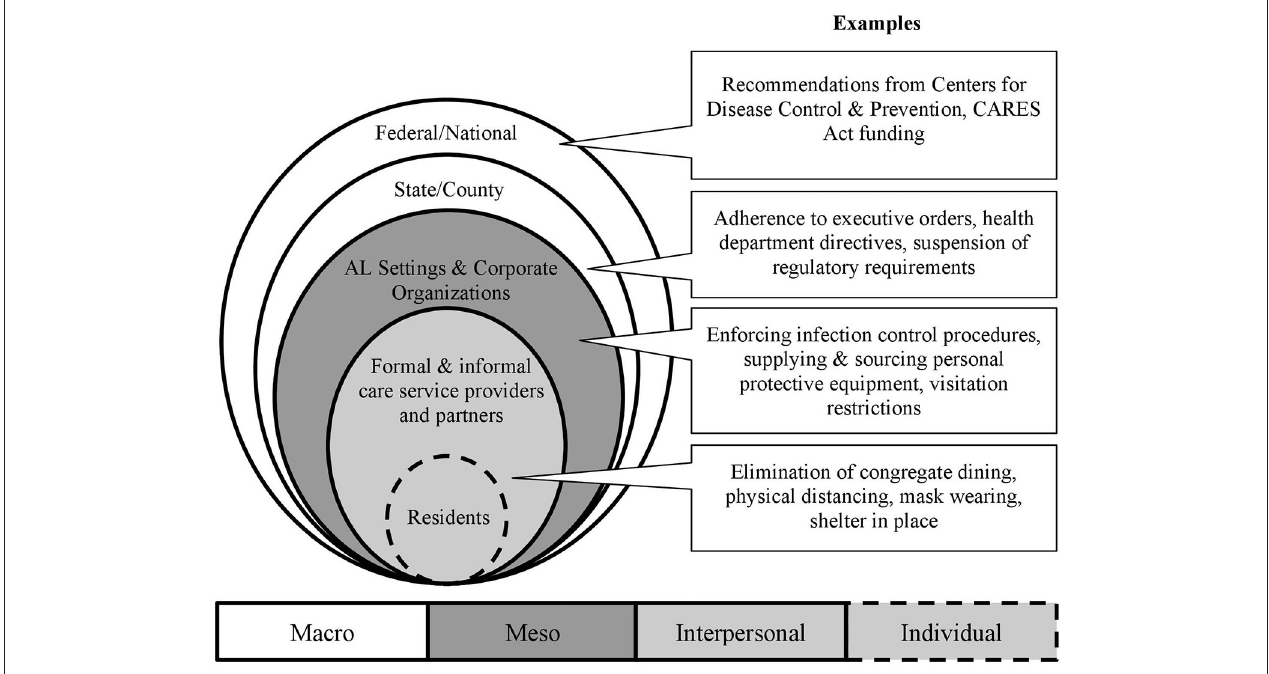
FIGURE 1 | Levels of COVID-19 policy response related to